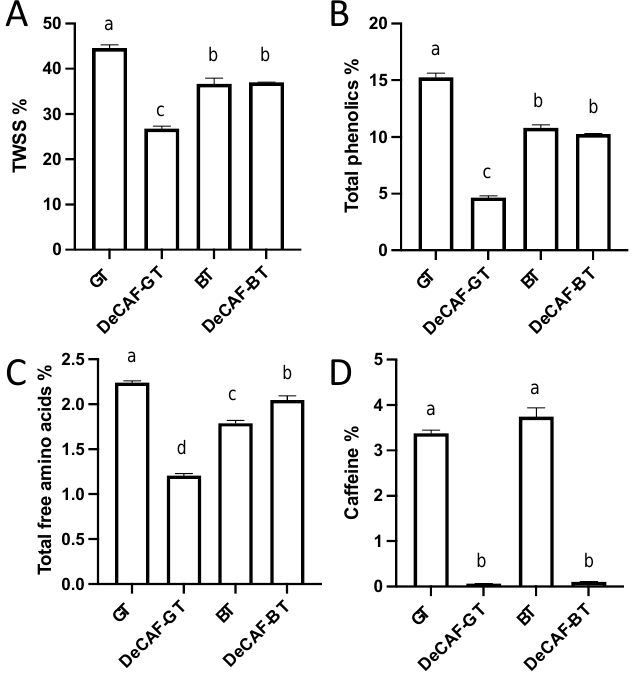
Figure 1. Contents of ( A ) total water-soluble solid (TWSS), ( B ) total phenolics, ( C ) total free amino acids, ( D ) caffeine of the green tea (GT), decaffeinated green tea (DeCAF-GT), black tea (BT), and decaffeinated black tea (DeCAF-BT). Different letters indicate significant differences ( p < 0.05).